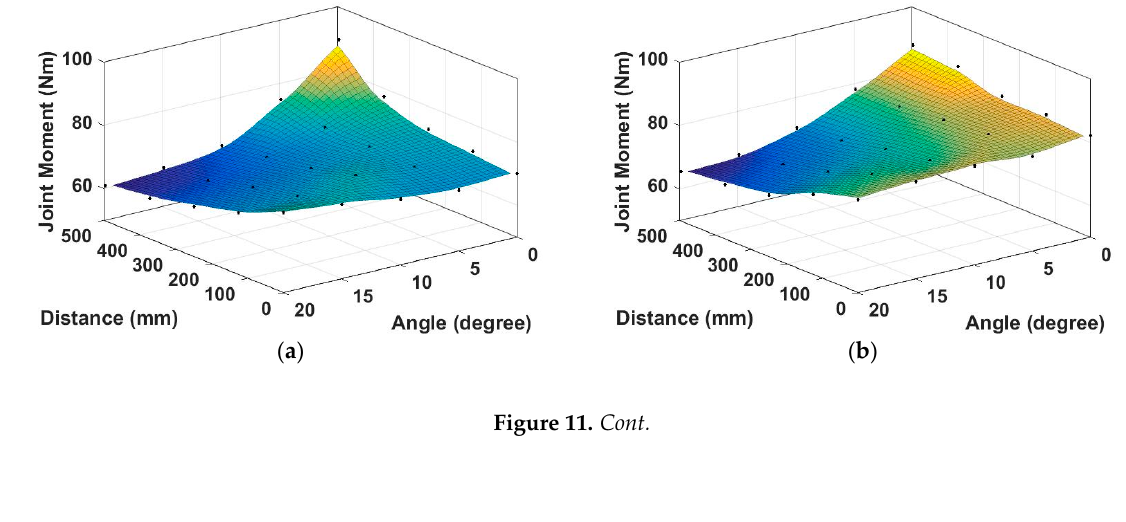
Table 8. NRMSEs of measured and simulated joint moments. Independent Variables